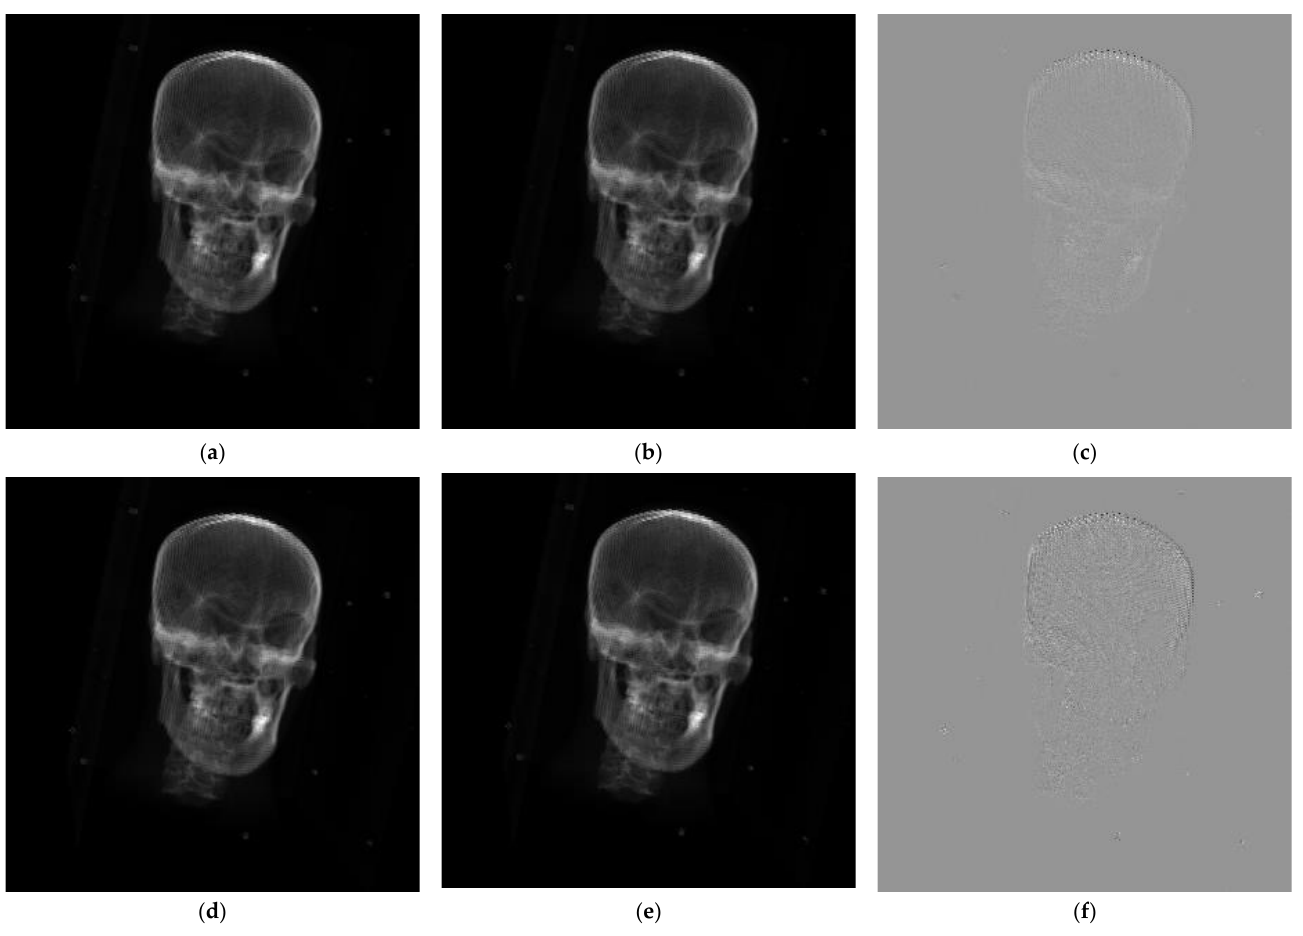
Figure 6. Result of Experiment 3: ( a ) reference image 3; ( b ) DRR image based on WSHGD registration; ( c ) difference image after registration based on the WSHGD; ( d ) reference image 3; ( e ) DRR image registered based on WHGD; ( f ) difference image after registration based on the WHGD.